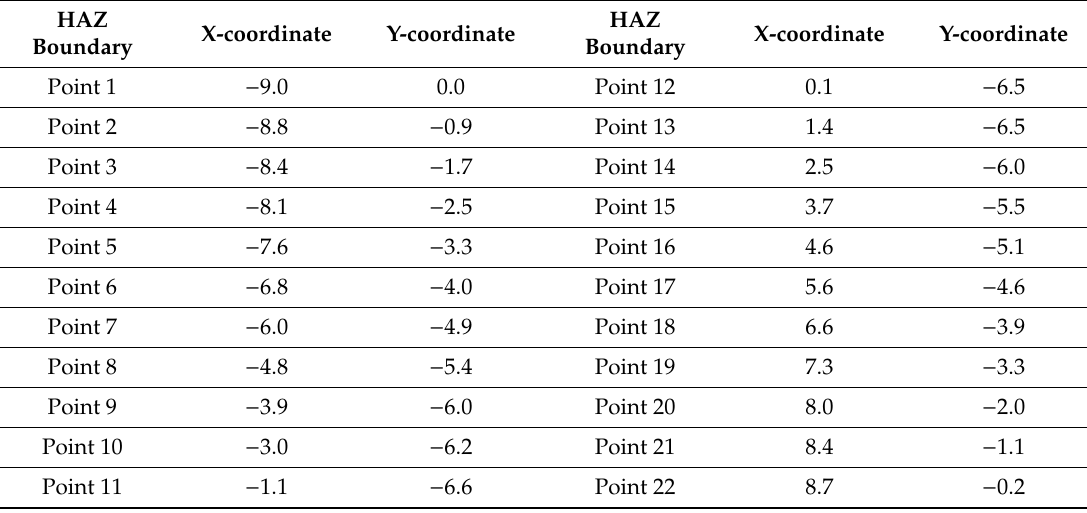
Figure 6. Weld bead and Heat Affected Zone (HAZ) geometry. Table 4. HAZ boundary coordinates.